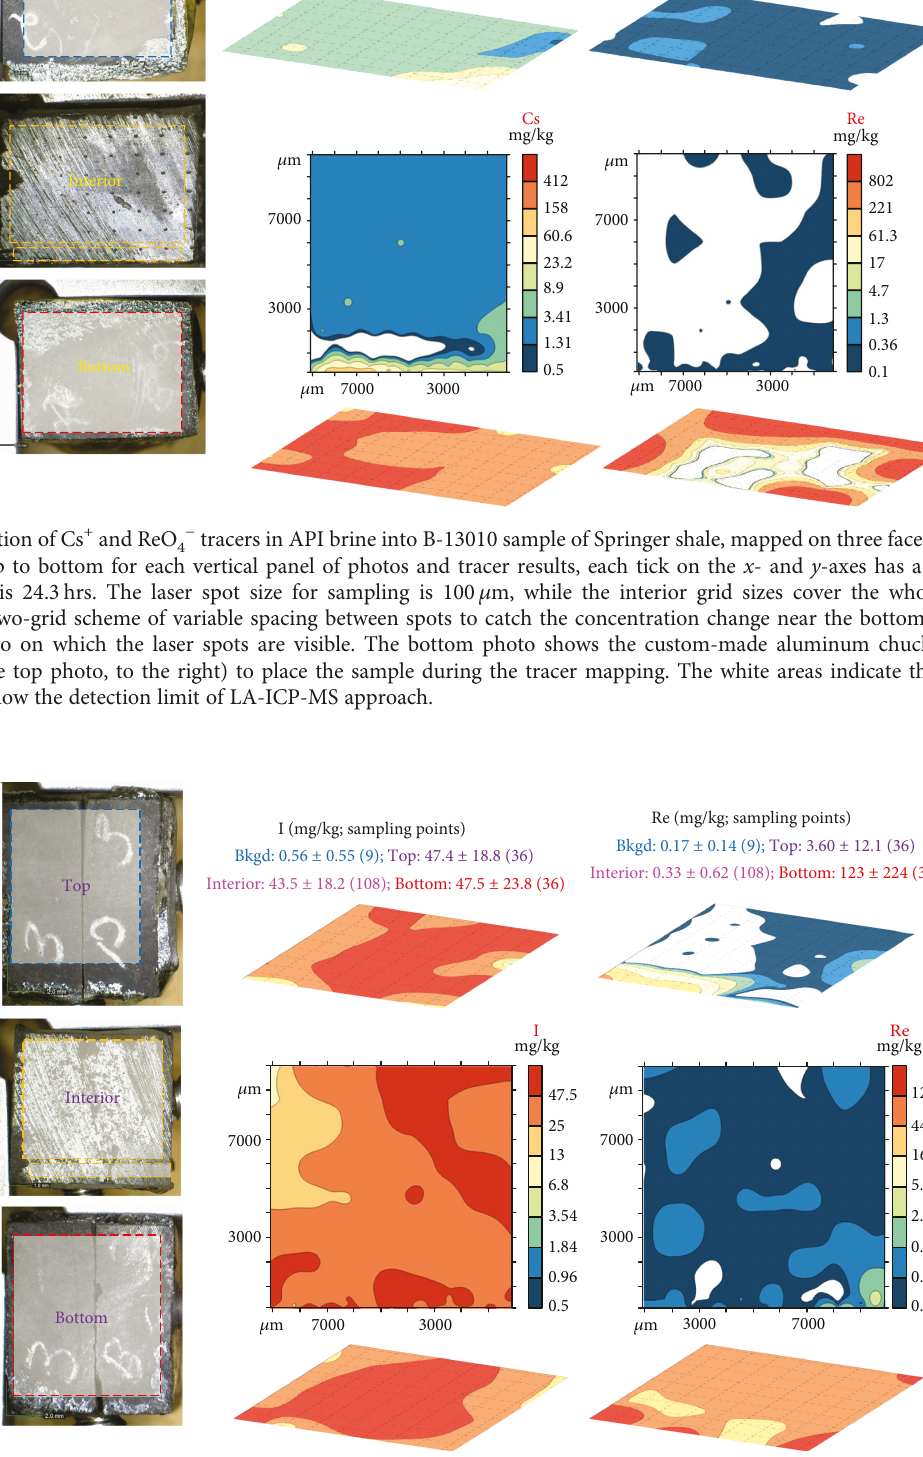
Figure 9: Imbibition of organic-I and organic-Re in n-decane into B-13010 sample of Springer shale after the imbibition time of 23.5hr, corresponding to Figure 7c. The interior face is sawed open from the top to the bottom, as shown in the top, interior, and bottom photos. Labeling of 3, B, and P indicates that this is cube number 3, bottom face, and imbibition direction is parallel to the